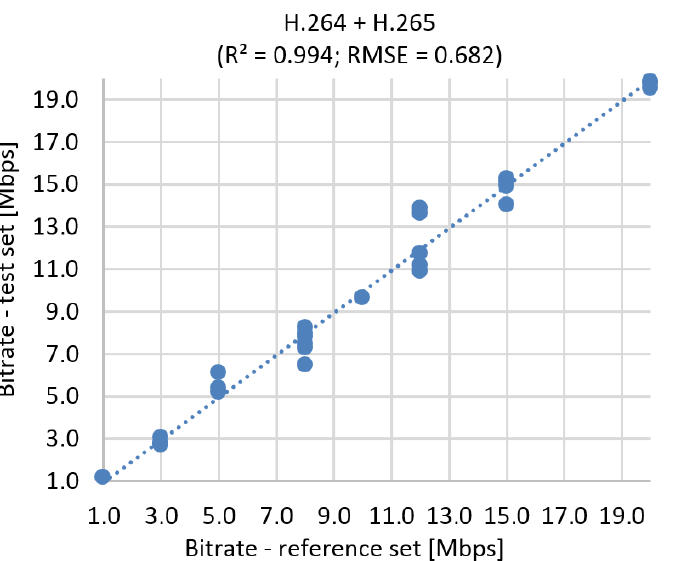
Figure 25. Correlation diagram for bitrate prediction based on MOS, Ultra HD, H.264 + H.265.